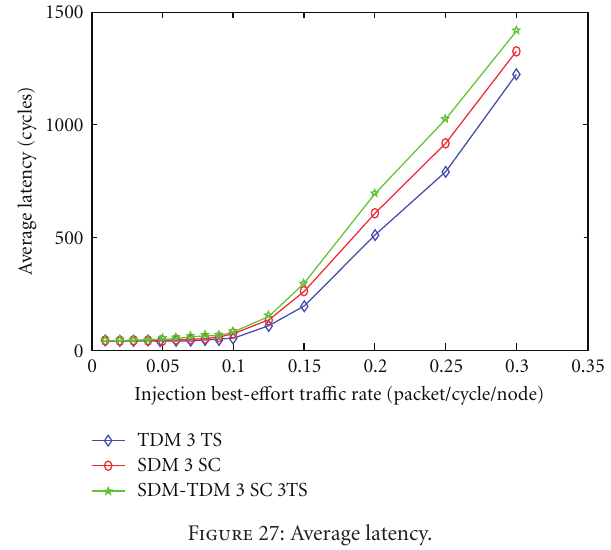
Table 4: Synthesis results TDM router.